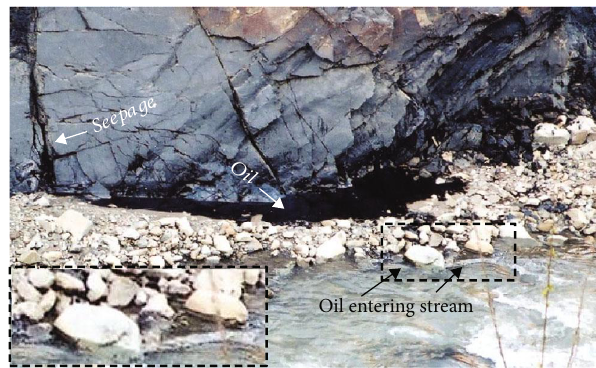
Figure 15: Photo of oil accumulation in the Santa Paula River from riverbank seepage. Tar is visible in fractures in the exposed rock matrix. Inset shows an enlarged area where oil enters the water and fl ows downstream. Photo: Ken Wilson and Ira Leifer.